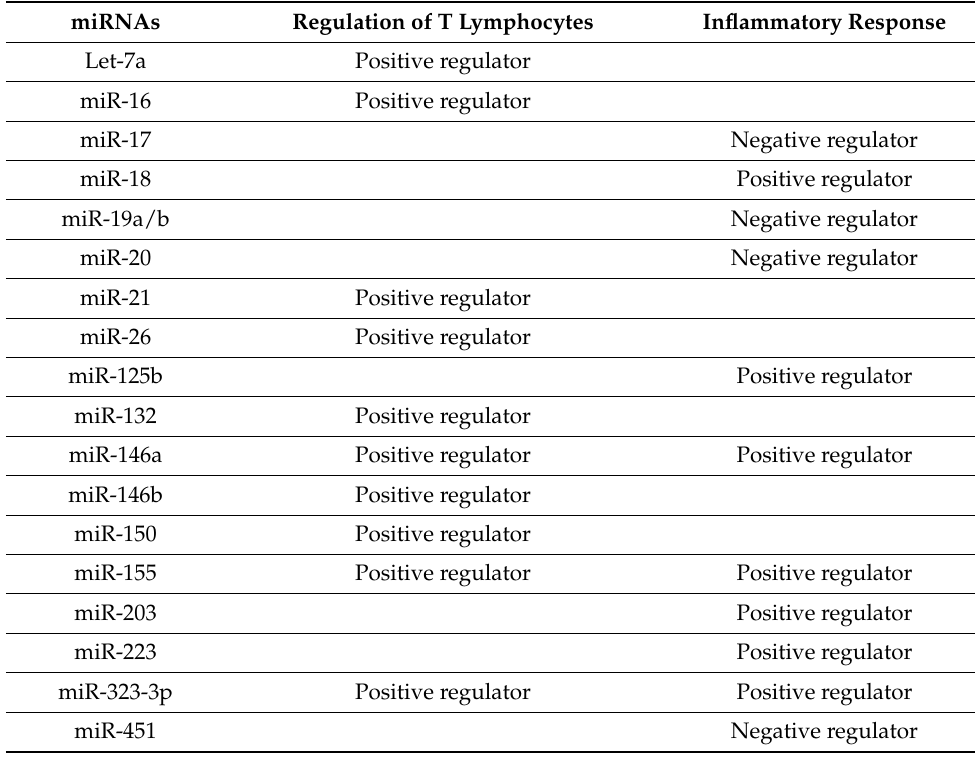
Table 5. Role of microRNAs (miRNAs) in immune and inflammatory responses in rheumatoid arthritis (RA)